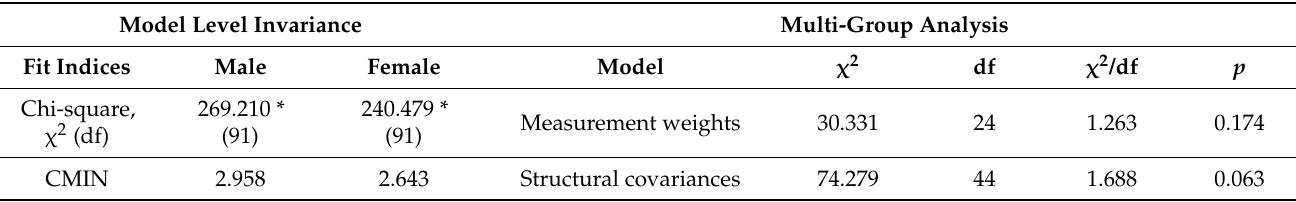
Table 6. Measurement Invariance based on the Sex of the